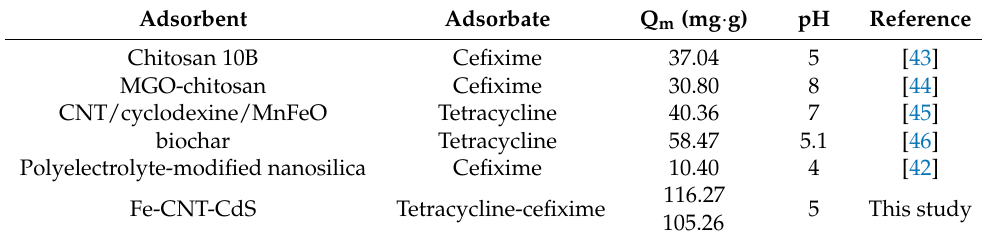
Table 4. Comparison of adsorption capacity of different